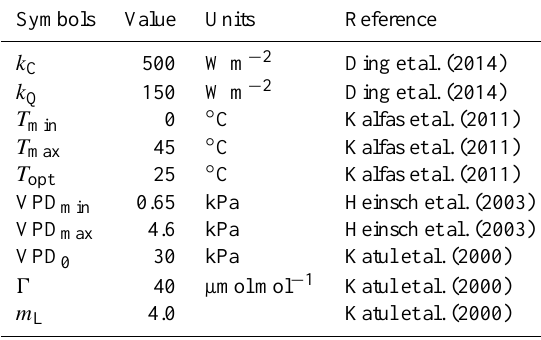
Table A2. Values for model